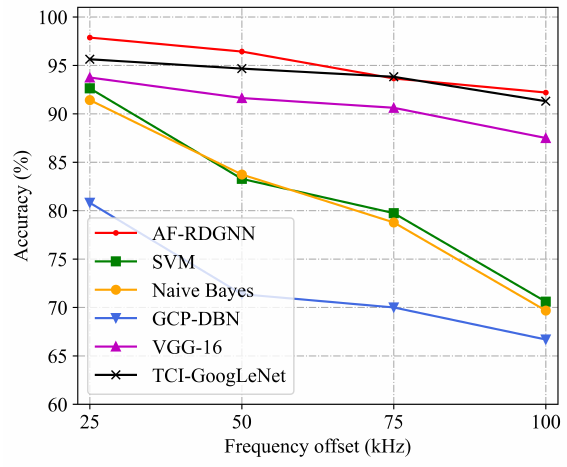
Figure 6. Comparison of the recognition accuracy of different methods when the SNR is − 5 dB.